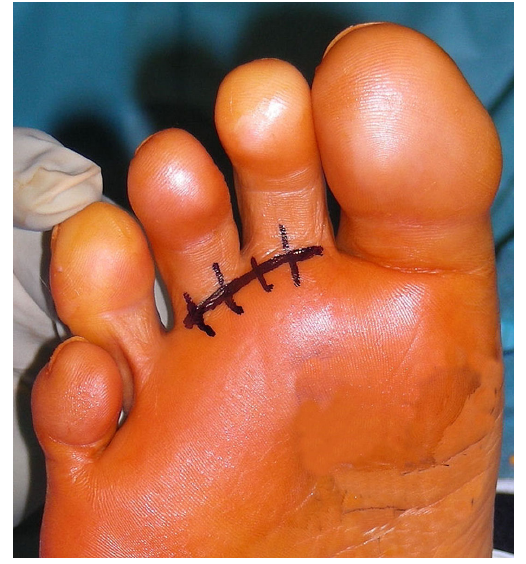
Figure 1: Distal transverse plantar incision to the second web